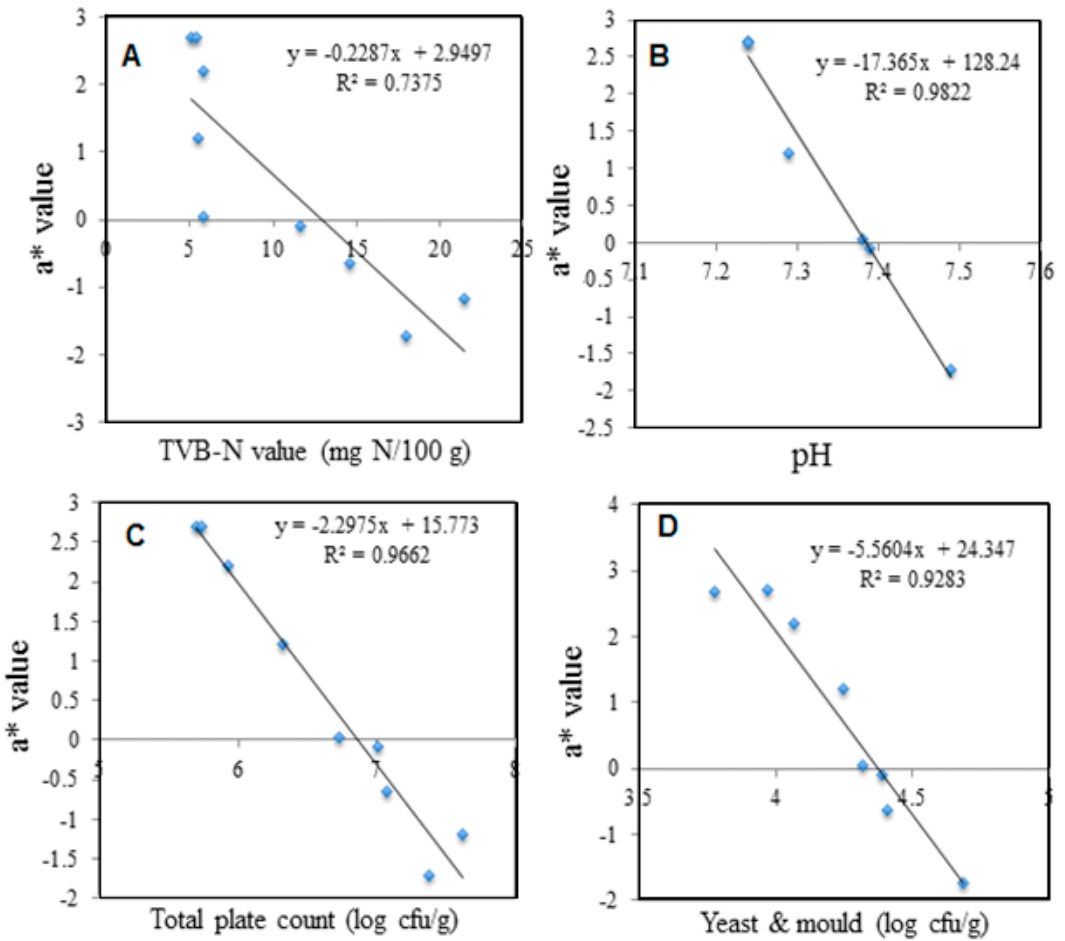
Figure 6. Correlation between a* value of colorimetric pH sensor film with parameter analysis of shrimp samples—( A ) TVB-N concentration; ( B ) pH value—( C ) Total plate count (TPC); ( D ) Yeast and mold counts.